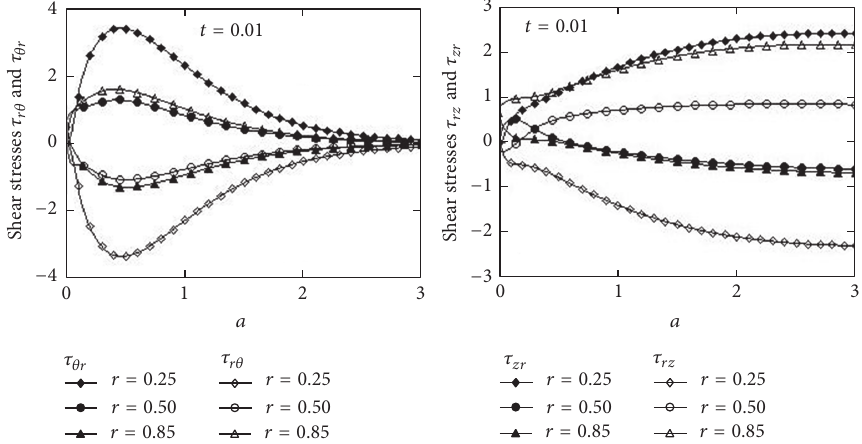
Figure 4: The variation of shear stresses with the scale parameter 𝑎